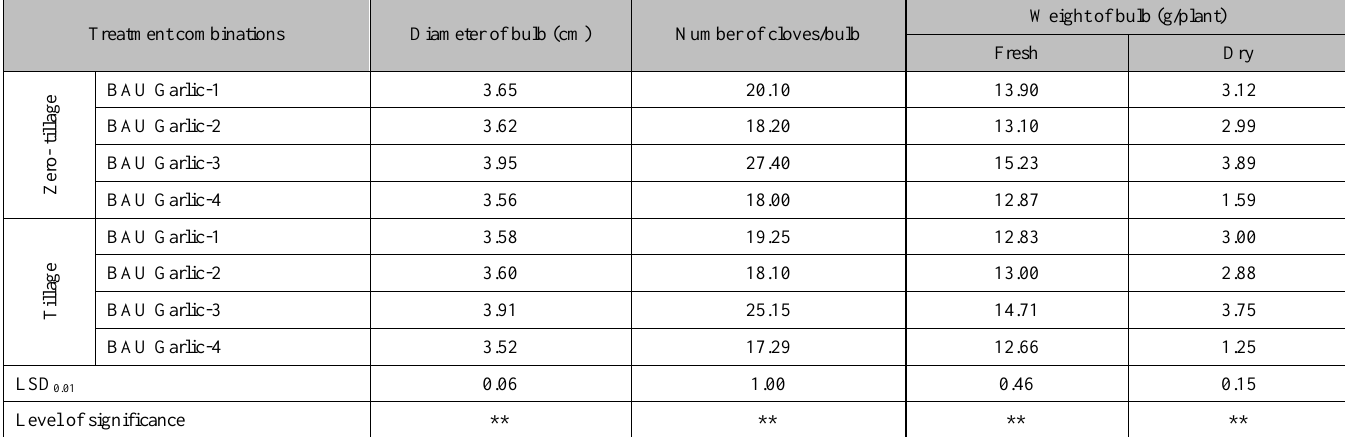
Table 8. Combined effects of planting system and variety on diameter of bulb, number of cloves/bulb, fresh and dry weight of